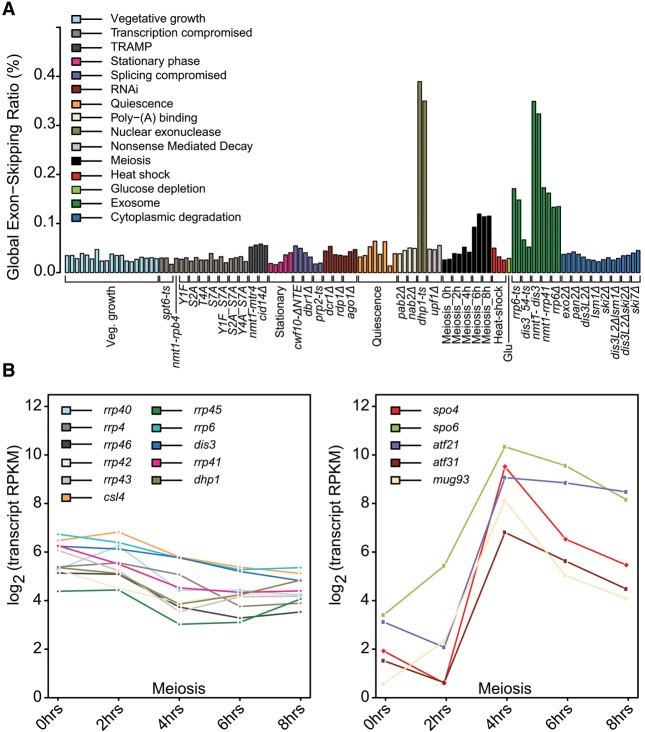
Exon-skipping events are rare but accumulate in nuclear surveillance mutants and meiosis. (A) Sample-specific global exon-skipping ratio (ESR), reflecting the proportion of exon-skipping reads among total exon–exon junction reads. Physiological conditions or mutants as indicated below were grouped and color coded according to cellular function or condition tested (Supplemental Table S1). (B) RNA-seq expression profiles of selected transcripts during meiotic differentiation. (Left) Exosome subunit and nuclear exonuclease transcripts. (Right) Selected transcripts known to increase during meiosis (Mata et al. 2002). Mean expression of two biological replicates is shown at each time point (RPKM, reads per kilobase per million). The decrease in nuclear-exosome transcripts is significant (P-adjust < 0.05, DESeq) (Anders and Huber 2010).